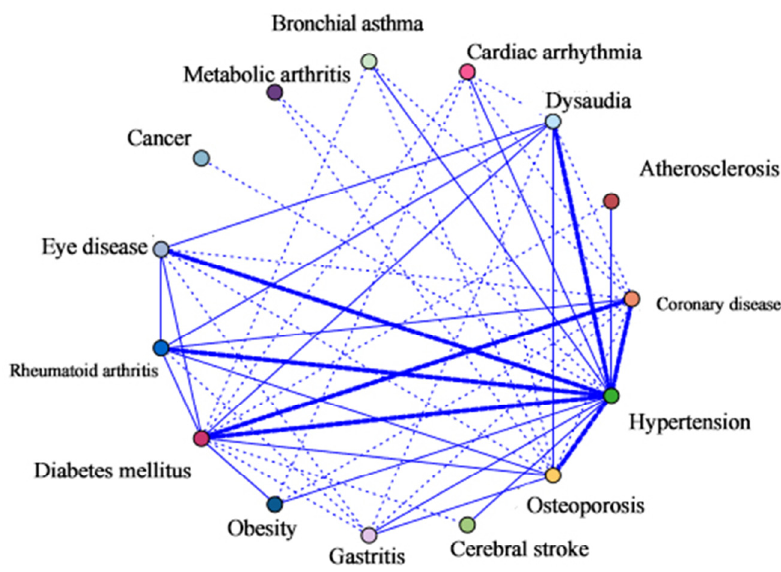
Figure 2. Web graph of association between chronic diseases. Table 2. Analysis results of multimorbidity dyads and triads by association